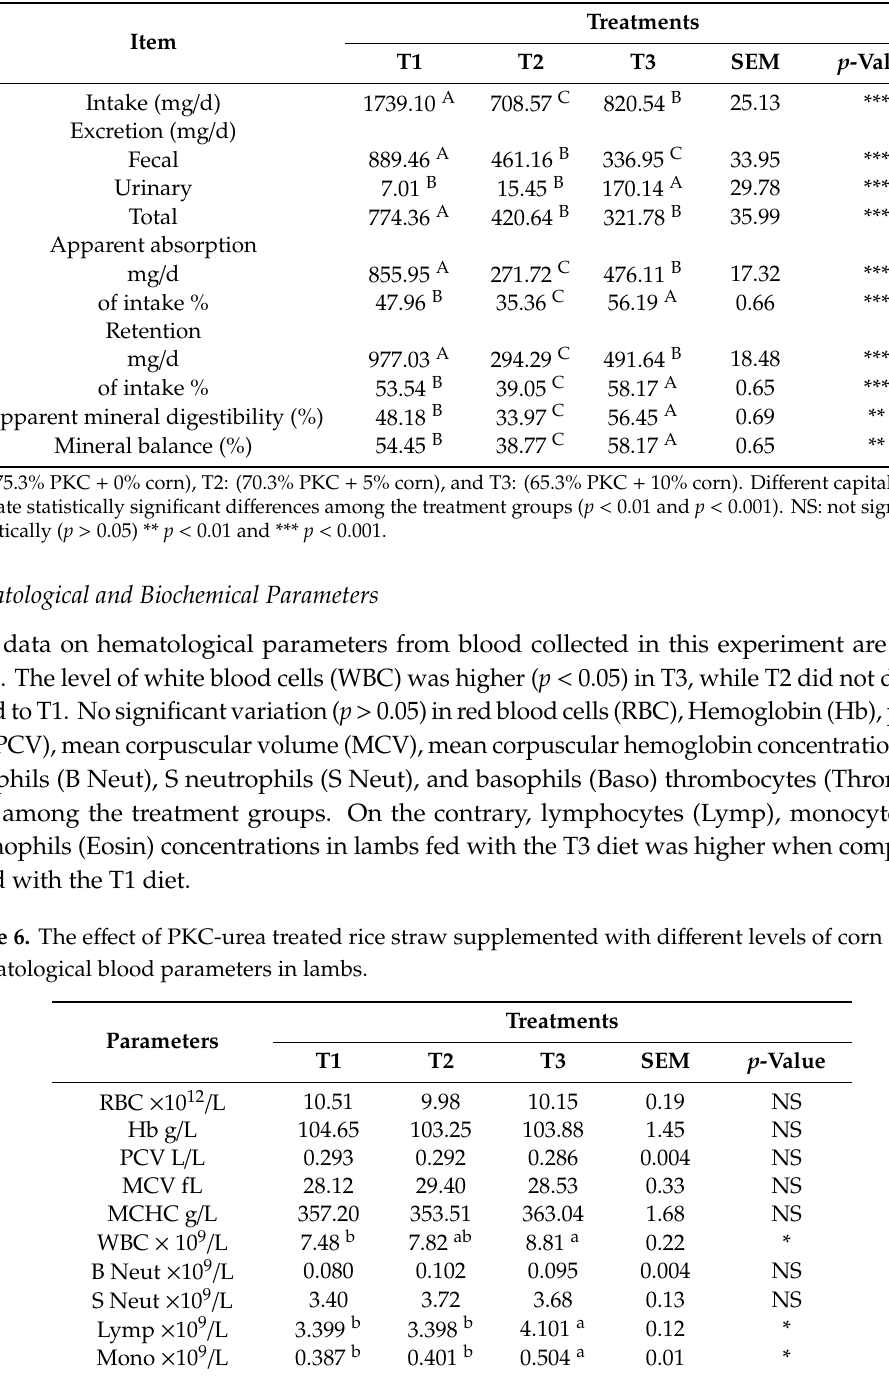
Table 5. Iron balance by Doper lambs fed with di ff erent levels of corn.